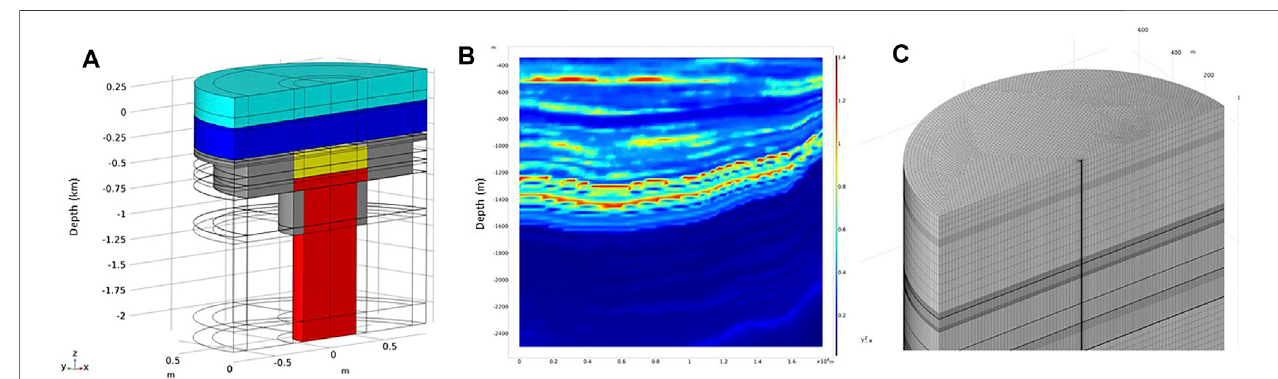
FIGURE 4 | (A) Zoom in the well structure including air (cyan), water (blue), cement (gray), plugs (yellow), and the well borehole (red). The horizontal axis is not to scale. (B) Background (formation) resistivity model (in Ω m ) from Gehrmann et al. (2021). (C) Mesh design based on the well structure.